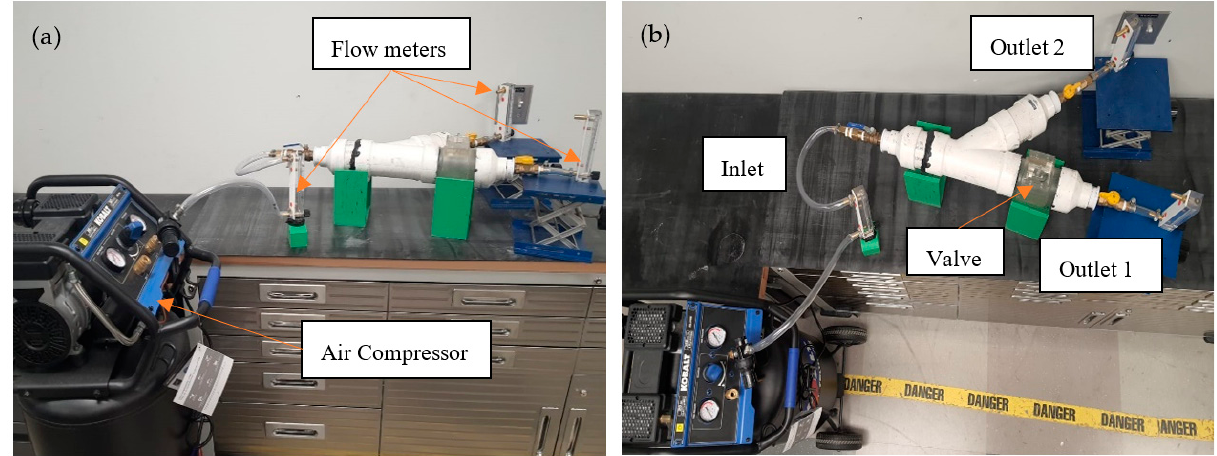
Figure 4. Experimental setup of the valve ( a ) side view, ( b ) top